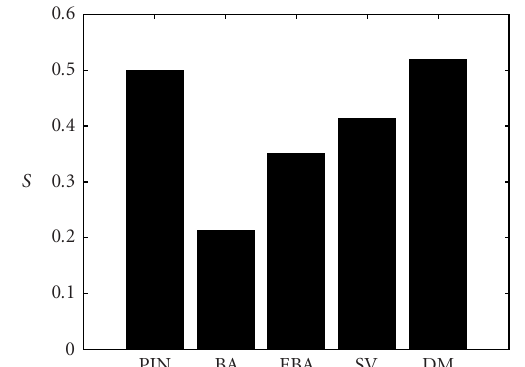
Figure 3. Magnitude of slope S , for the PIN data and di ff erent models (measured yeast protein interaction network (PIN) (data as in Figure 1b); the models are Barabasi-Albert (BA); extended BA (EBA); Sole-Vazquez (SV); duplication mutation (DM)). S measures the decrease of variance of the betweenness values of proteins with increasing degree, and hence indicates the relative prevalence of HBLC proteins.